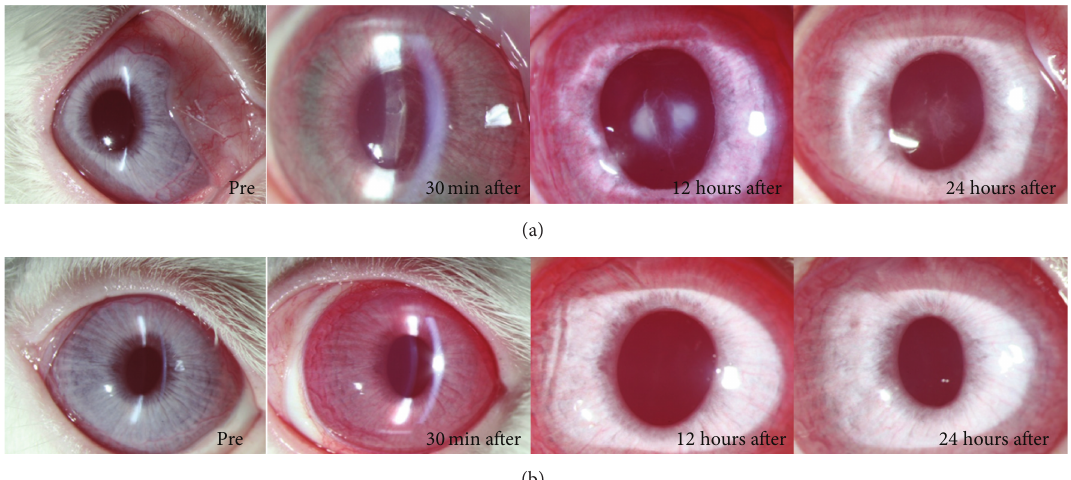
Figure 2: Fibrous membrane in the anterior chamber was observed immediately after applying ICG to the right eye of Rabbit Number One (a). It was more pronounced at 12 hours after the injection and then disappeared within 24 hours. The control eye was clear at all times (b).